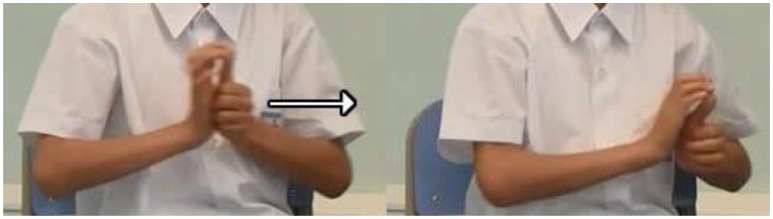
An example of Vcomplex meaning “the cat pushes the backpack”.